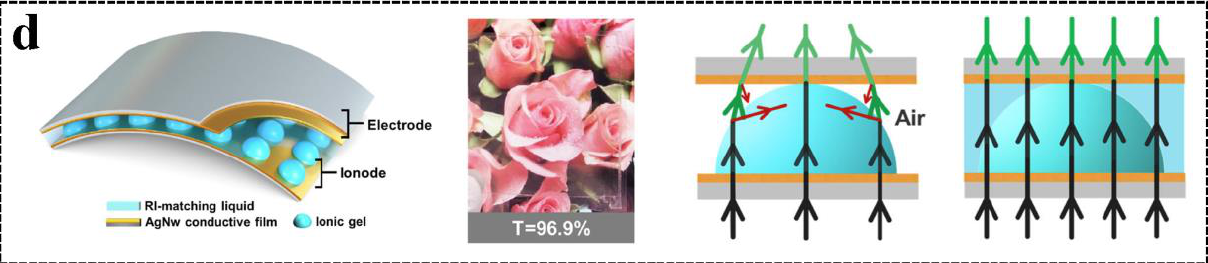
Figure 5. Tactile and force sensors with wearing fitness: ( a ) A stretchable tactile sensing array using patterned PI films. Reproduced with permission [120], Copyright 2019, American Association for the Advancement of Science. ( b ) A multimodal flexible sensing array using AgNW as the electrode. Reproduced with permission [11], Copyright 2020, Wiley-VCH. ( c ) A capacitive pressure sensor with stable pressure sensing property under bending conditions. Reproduced with permission [126], Copyright 2022, Springer Nature. ( d ) An iontronic capacitive pressure sensor filled with liquid to have high transparency. Reproduced with permission [130], Copyright 2022, Springer Nature.